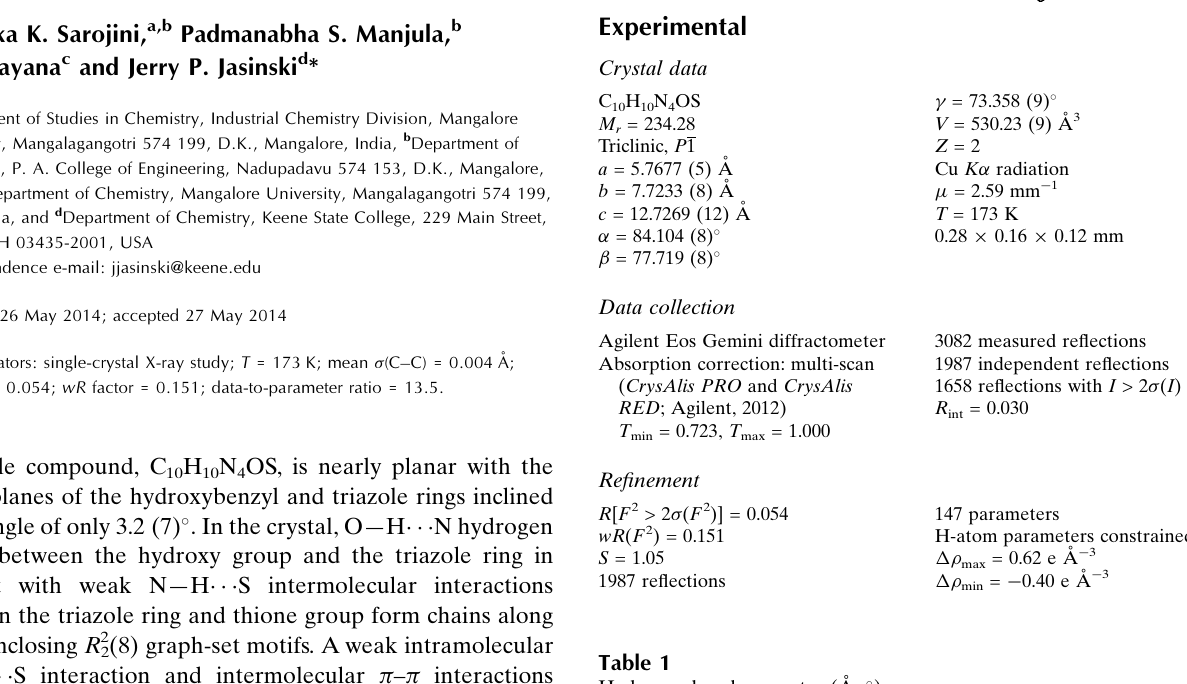
Hydrogen-bond geometry (A˚ , (cid:2)